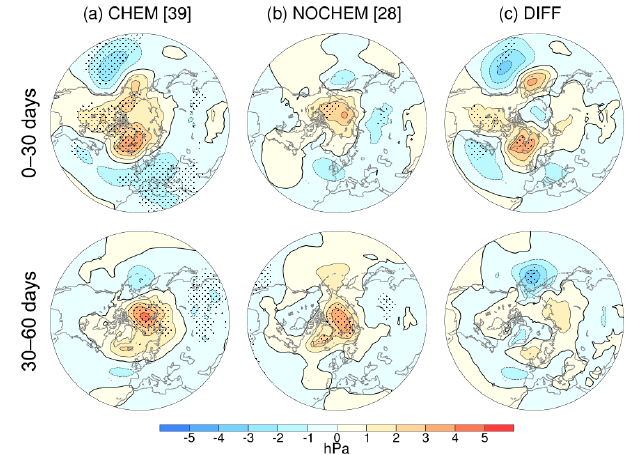
Figure 8. As in Fig. 3 but for March SSWs.